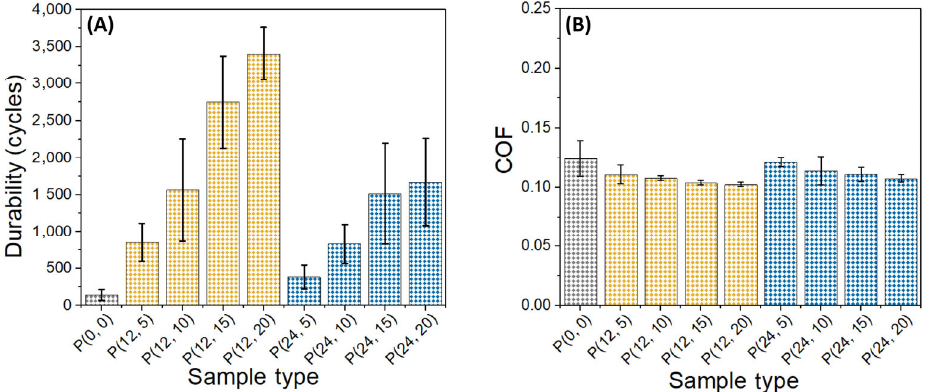
Fig. 10 Tribological test results: (A) durability and (B) COF of PDA/PTFE coatings on smooth and laser textured stainless